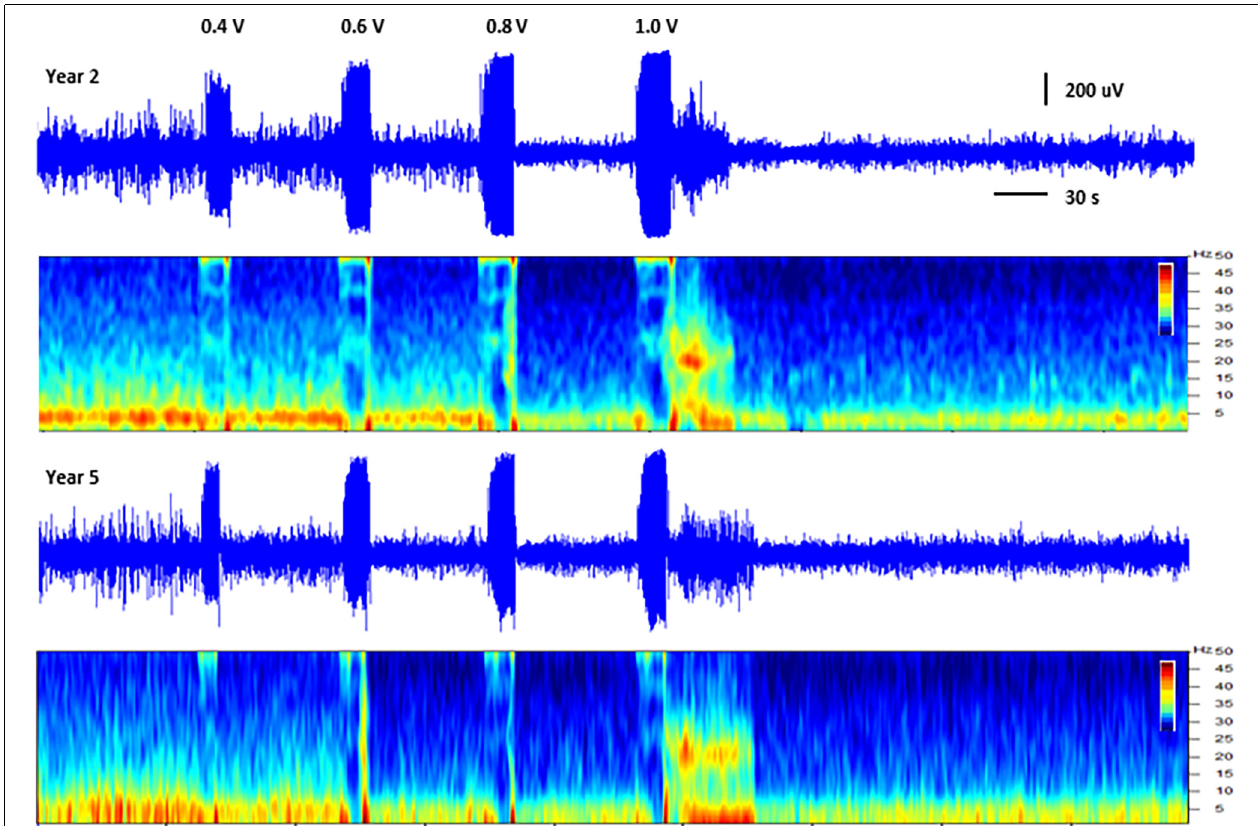
FIGURE 3 | Direct hippocampal stimulation. Hippocampal local field potentials (LFPs) and spectrograms (40 dB scale) recorded at approximately 15 months (year 2, top panels) and 57 months (year 5, bottom panels) post-implant from subject C1 illustrating the response to stimulation of the hippocampus. Stimulation was delivered to contacts HC E1-C+ at the amplitudes shown (50 Hz, 10 s ramped burst, 300 µ s PW) while recording from contacts HC E0-E2. The large signal below the amplitude labels represents the recorded stimulus